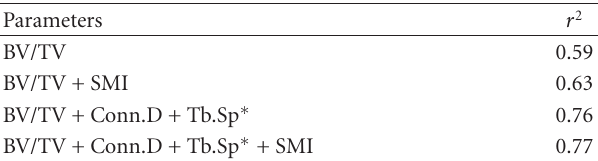
Figure 2: Scatter plot of Buckling index versus UFS (bone strength), showing a statistically significant relationship ( r 2 = 0.56; P < .0001).